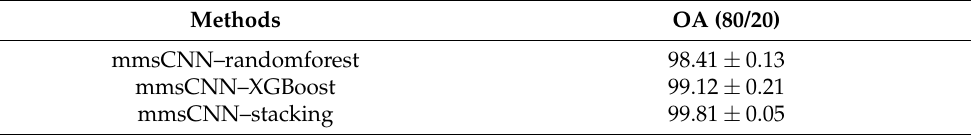
Table 2. Comparison of ensemble learning methods on the UCM dataset.